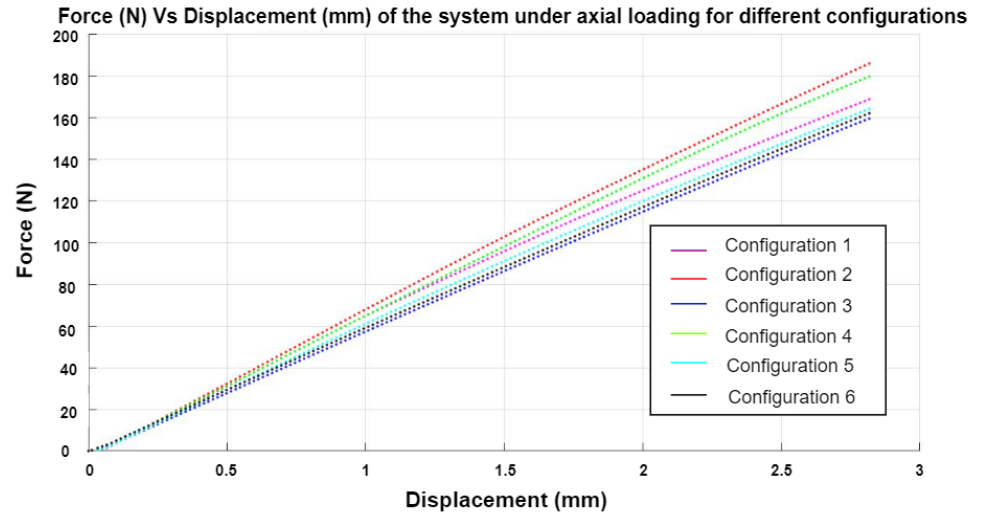
Figure 15. System test behavior for each configuration. Configuration 1—Magenta, Configuration 2—Red, Configuration 3—Blue, Configuration 4—Green, Configuration 5—Cyan, Configuration